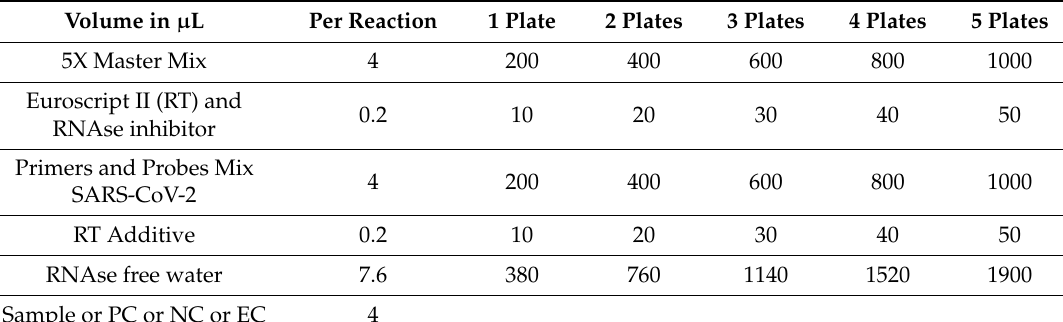
Table 3. Composition of the SARS-CoV-2 PCR Mix.